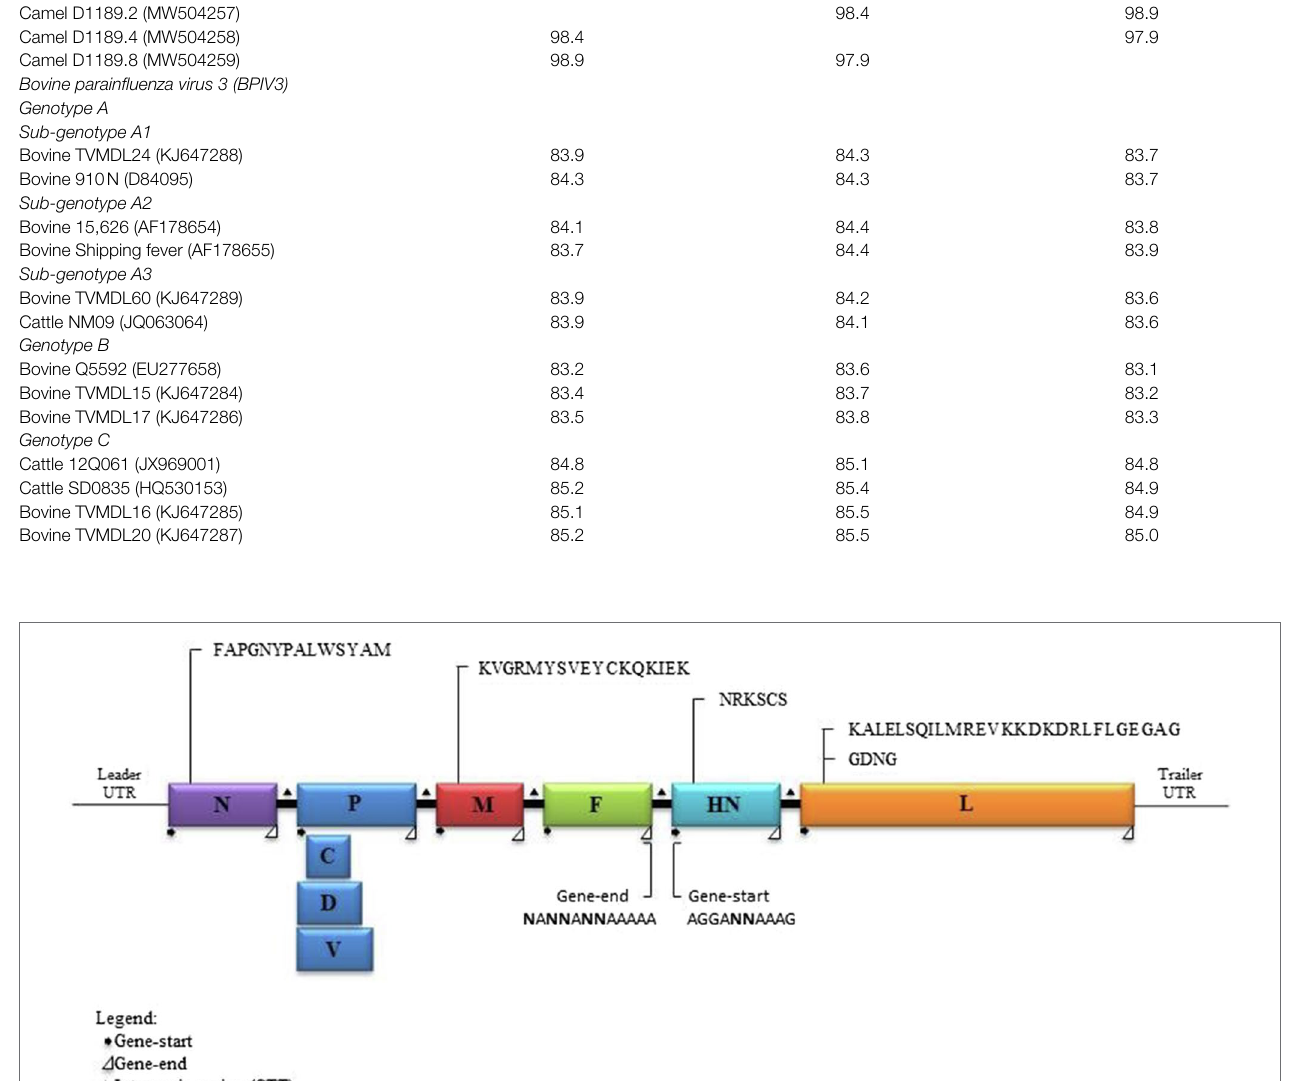
PIV3 strain (GenBank accession no.)